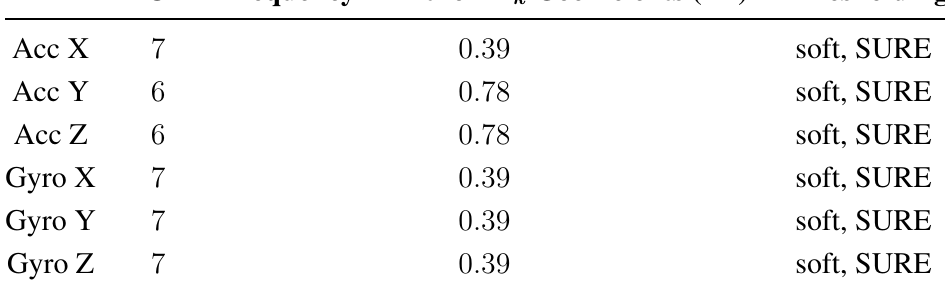
Table 7. Wavelet de-noising parameters for each sensor under kinematic